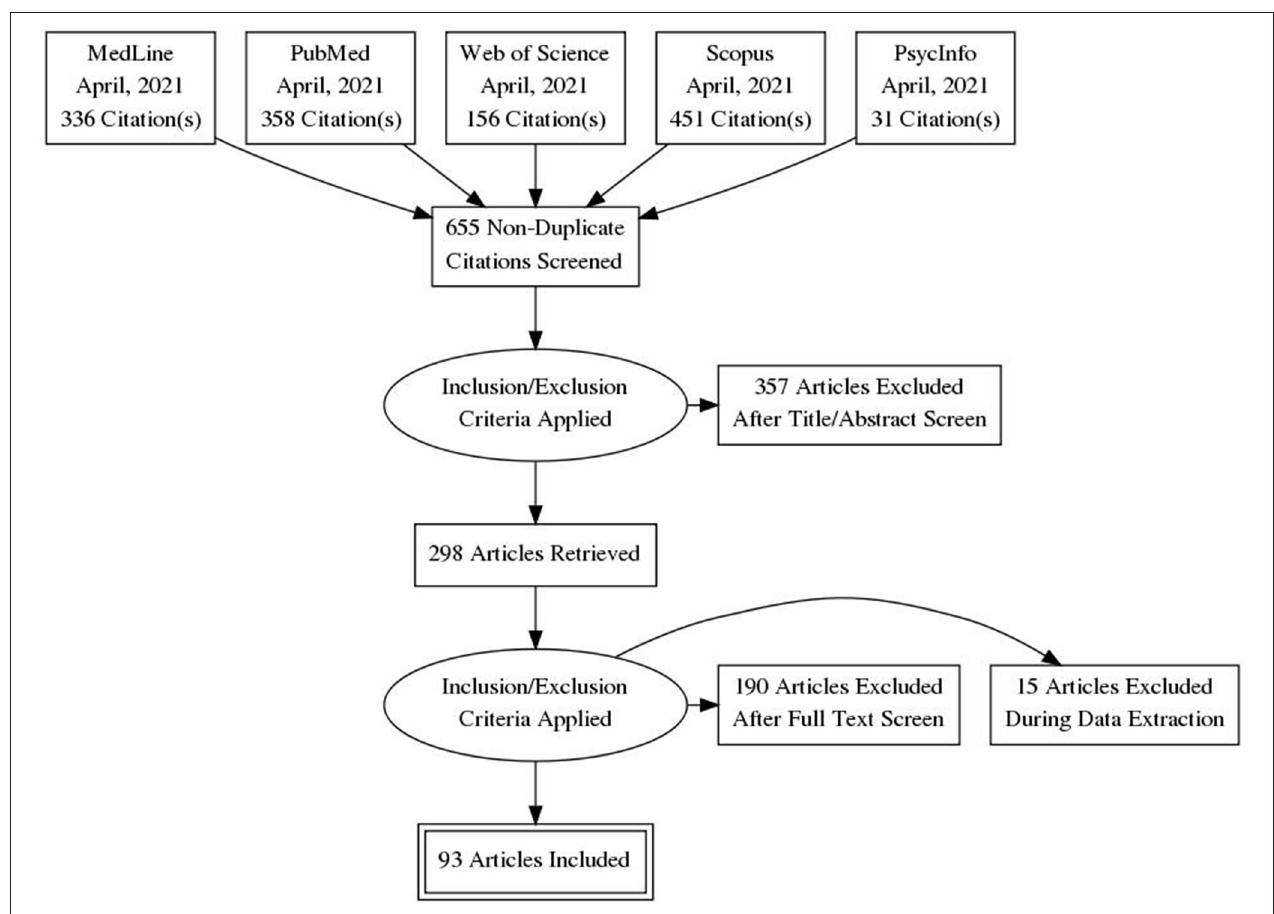
FIGURE 1 | Flow diagram of the study